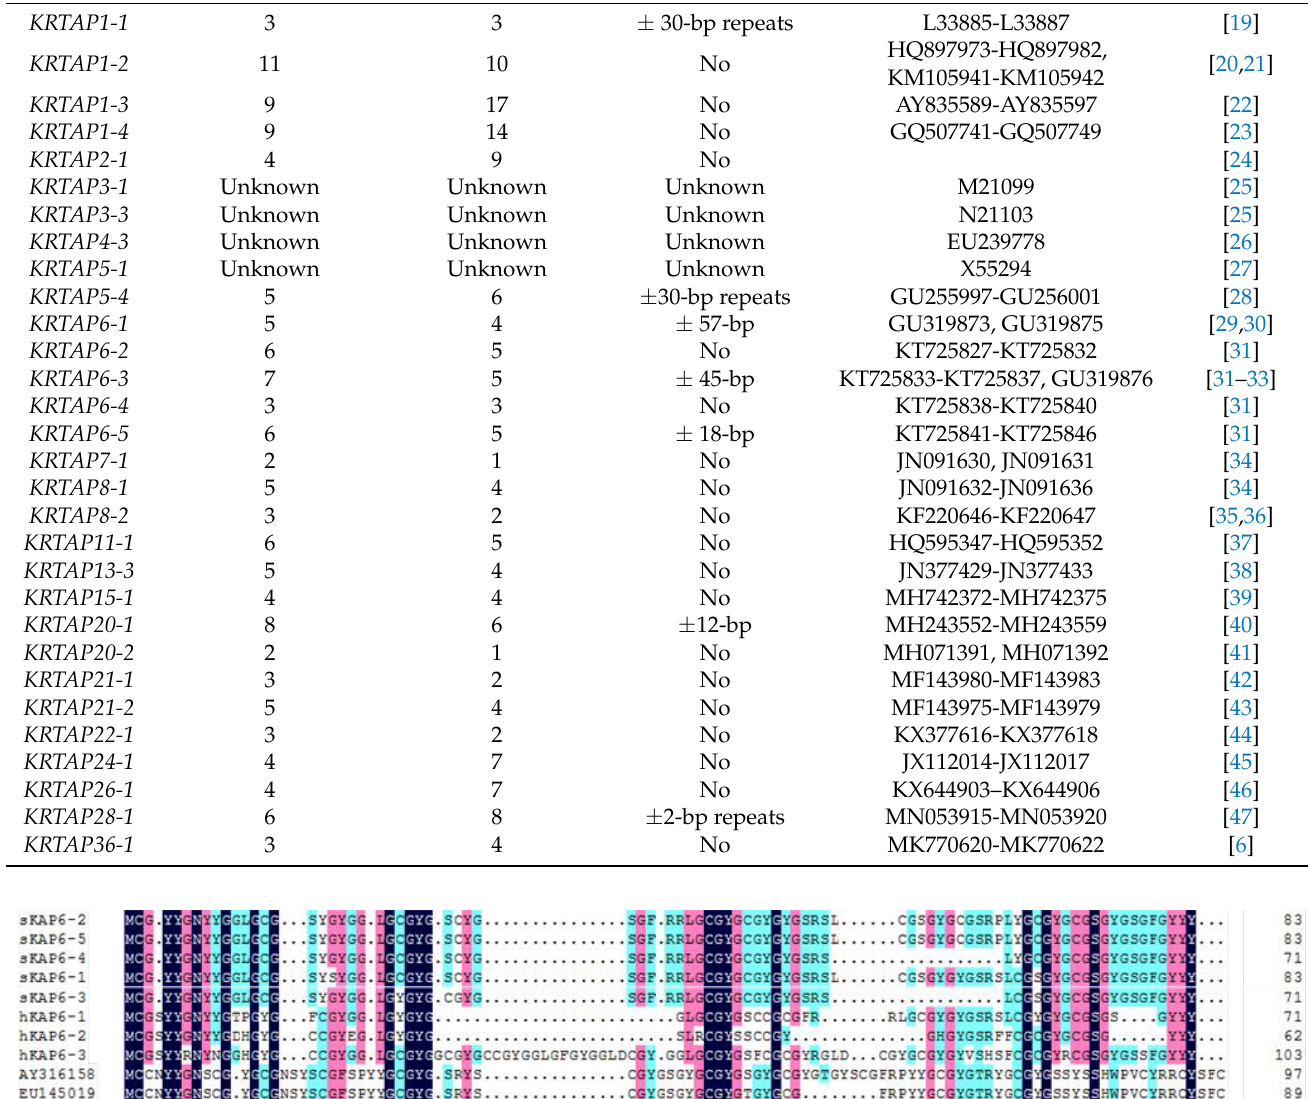
Figure 1. Comparison of the predicted amino acid sequences of two goat “ KRTAP6-2 ” sequences with sheep and human KRTAP6 sequences. The goat “ KRTAP6-2 ” sequences are indicated with the GenBank accession number AY316158 and EU145019. The sheep sequences are indicated with the prefix “s”, while the human sequences are marked with the prefix “h”. The GenBank accession numbers of these sequences are NM_001193399 (sKAP6-1), KT725832 (sKAP6-2), KT725837 (sKAP6-3), KT725840 (sKAP6-4), KT725845 (sKAP6-5), NM_181602 (hKAP6-1), NM_181604 (hKAP6-2), and NM_181605 (hKAP6-3). The numbers on the right of the sequences represent the length of the proteins. Amino acid positions with high levels of homology are coloured, with black indicating 100% homology, red indicating greater than or equal to 75%, and blue indicating greater than or equal to 50%.